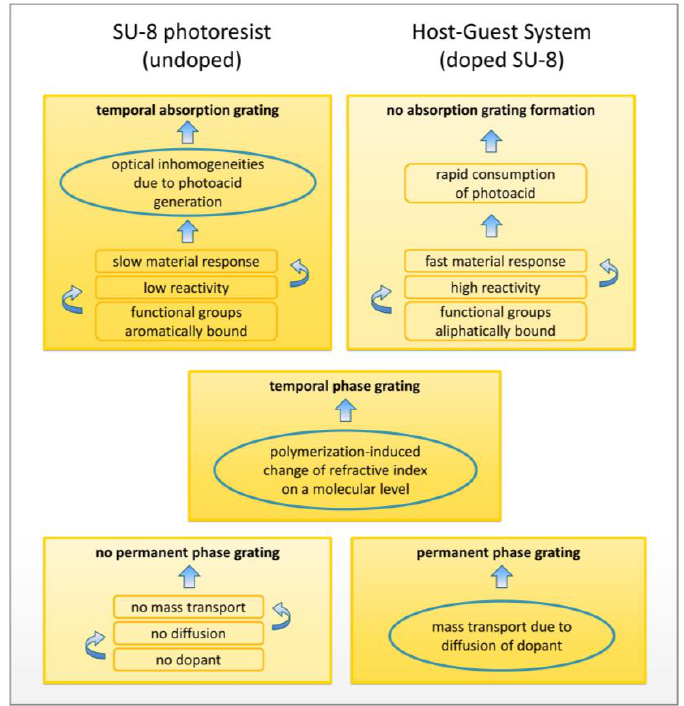
Figure 7. Overview of results and assumptions: Types of volume holographic gratings, found in doped and undoped SU-8, are contrasted. Results can be explained by specified attributes and underlying mechanisms, assumedly causing the presence or absence of respective gratings.